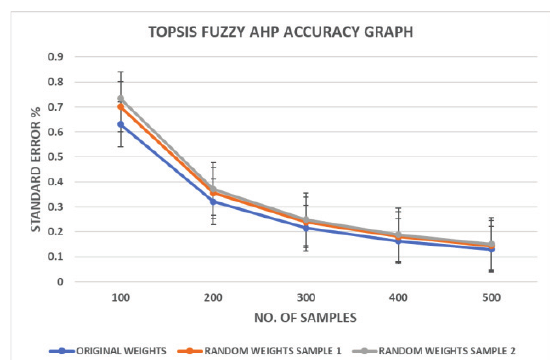
Fig. 4. Comparison of Standard Error by varying weights of Parameters